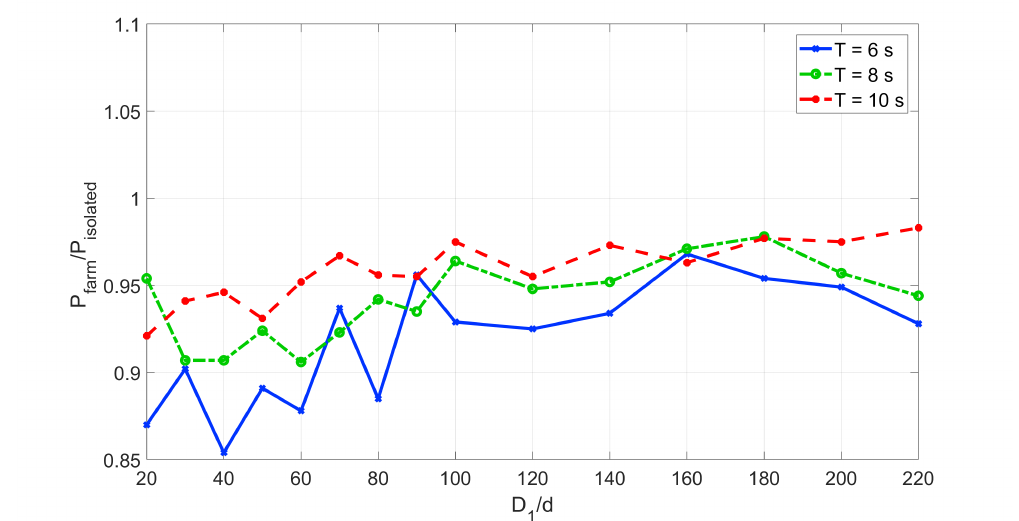
Figure 12. Ratio of P farm /P isolated for nondimensional distance D 1 / d , where d is the diameter of the WEC shown for irregular waves of T p = 6 s (solid line), T p = 8 s (dash-dot line), and T p = 10 s (dashed